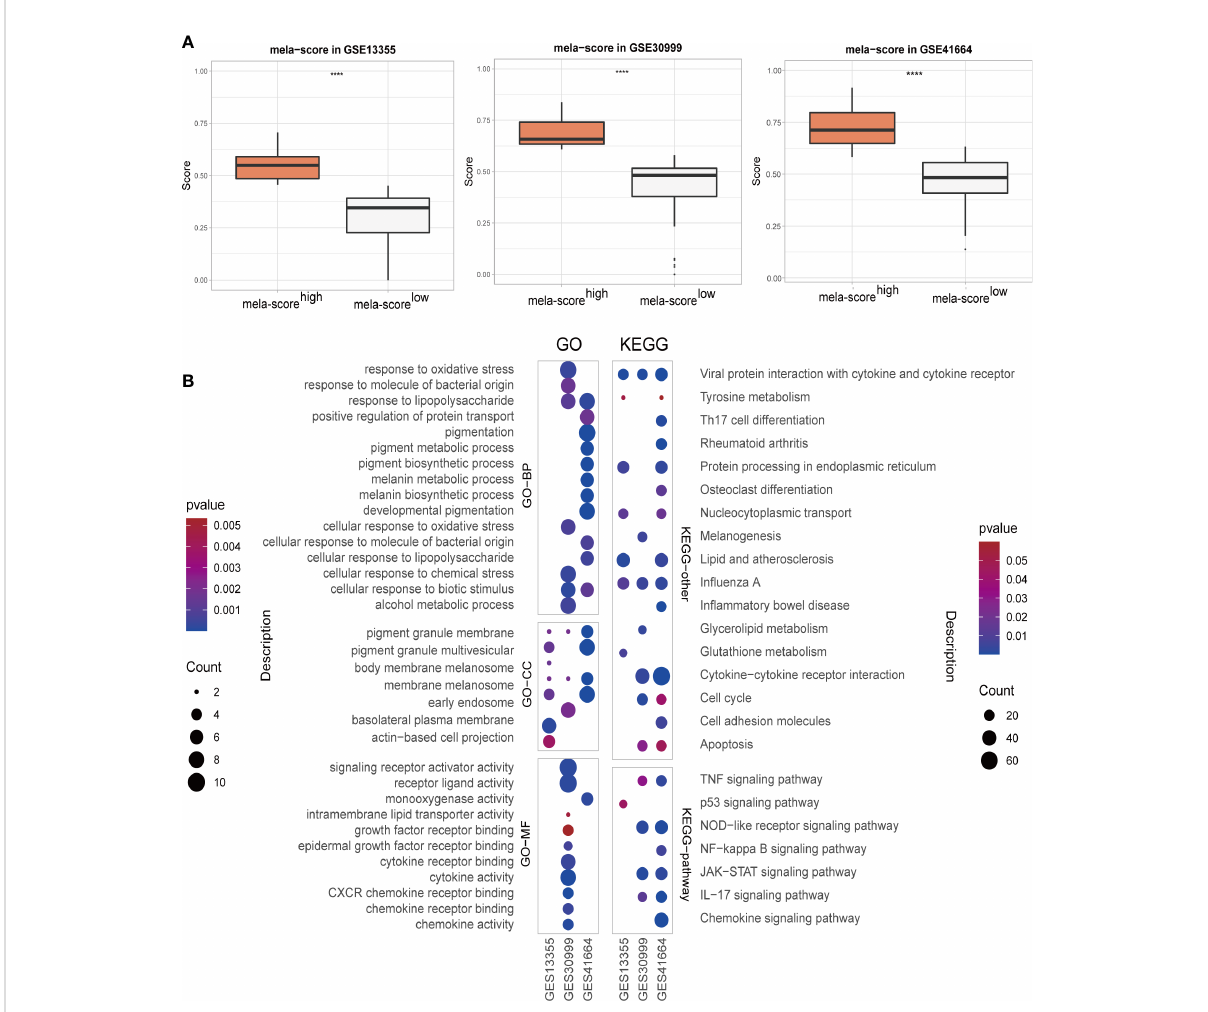
FIGURE 2 The overview of skin samples in 3 GEO datasets after regrouping. (A) Boxplot showing the weighted scores of melanogenesis-related genes. (B) GO and KEGG enrichment analyses results. ****P <